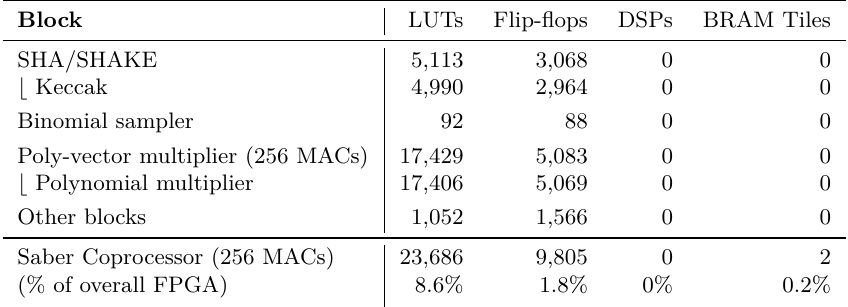
Table 2: Area results for the instruction-set coprocessor architecture for Saber (module dimension 3). The clock frequency constraint was set to 250 MHz in Vivado.